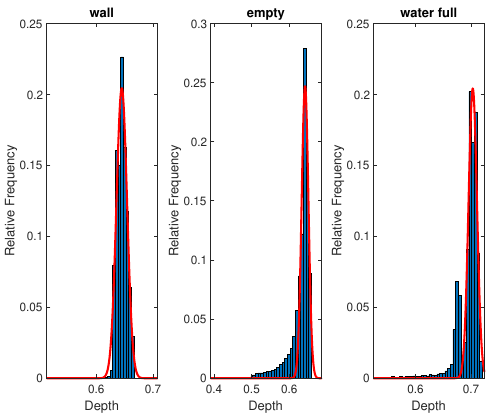
Figure 4. Normal distribution fitting of the depth estimates for L515 acquisitions.